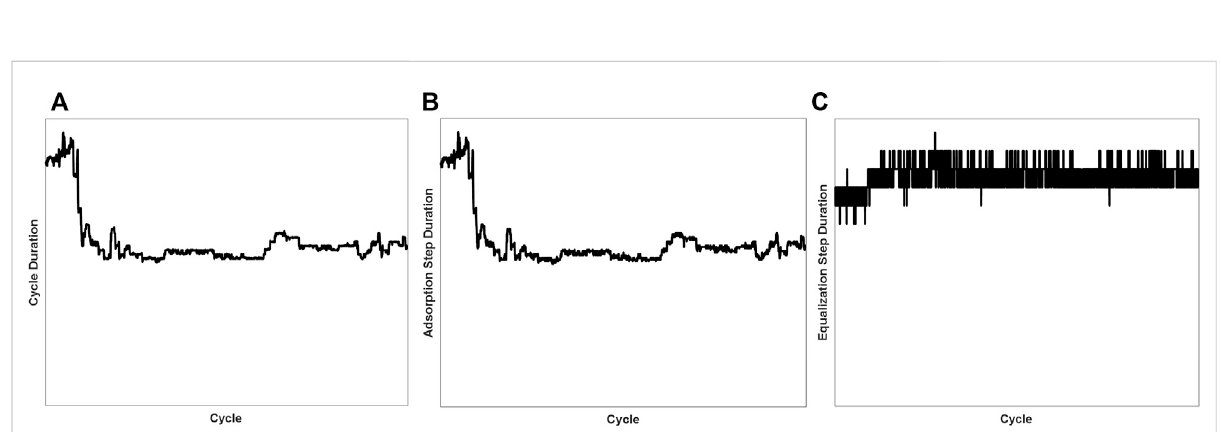
FIGURE 3 Illustrationsofthevariablecycleandstepdurations (A) Cycledurationsvarysigni fi cantlyfromcycletocycle (B) Durationsoftheadsorptionstep follow a similar trend as the cycle durations (C) durations of the equalization steps are close to